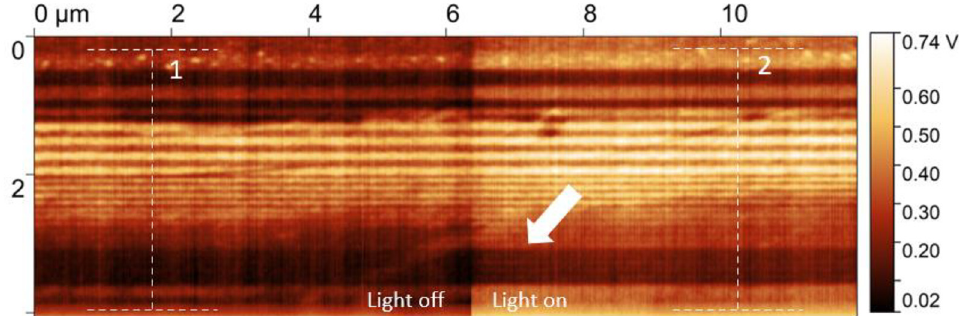
Fig. 5. KPFM measurement in ambient conditions on the surface cross-section of the InP sample in dark conditions (left half) and under white light illumination (right half). The resolution of the image is set to 1024 (cid:3) 1024 pixels per point.